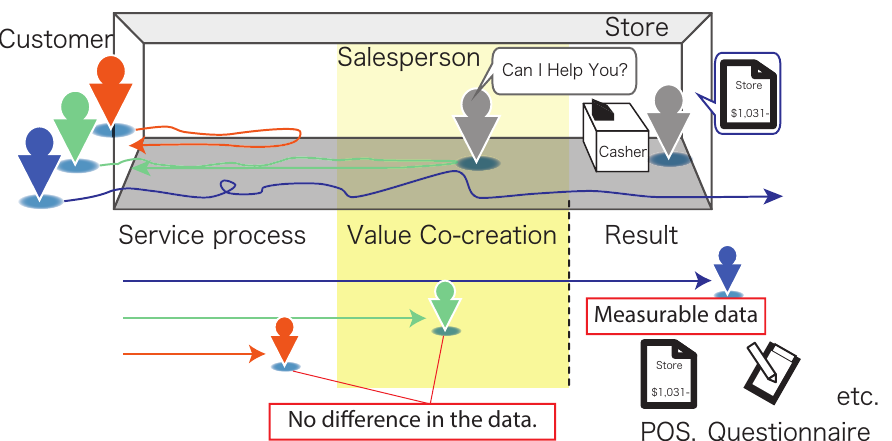
Figure 1. Value co-creation process of services that should be measured, which has been overlooked, considering customer service in retail stores as an